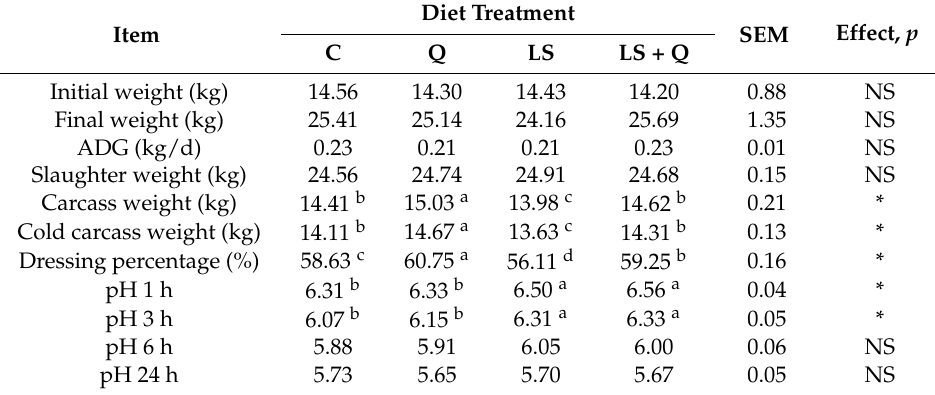
Table 3. Growth performance, carcass characteristics and pH of quadriceps femoris from lambs as affected by different diet supplementation (C = control; LS = linseed; Q = quinoa seed; LS + Q = linseed + quinoa) (means ±